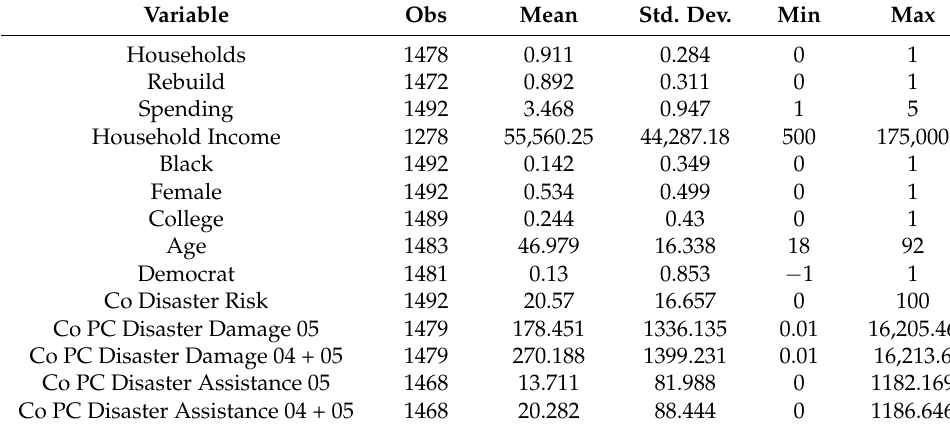
Table 1. Summary